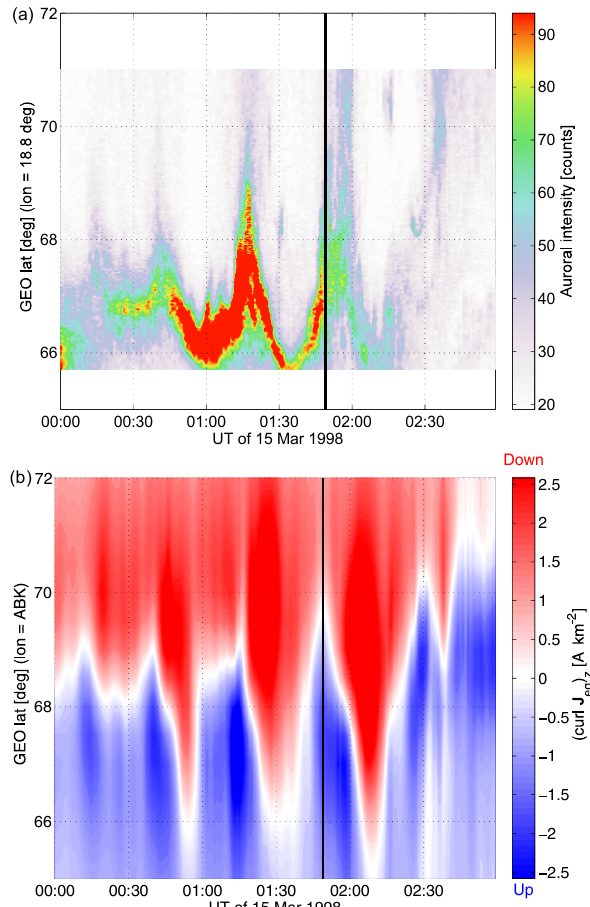
Figure 7. Evolution of the auroral brightness (a) and the equivalent current vorticity (b) as a function of time and geographic latitude for an omega event on 15 March 1998. The vertical line marks the individual omega structure in Fig. 6 at 01:49UT. Other omega struc- tures took place at 00:12, 00:17 and 00:40UT. The curl of the equiv- alent currents gives an estimate of the field-aligned current distribu- tion downward (red) and upward (blue) in Akm − 2 . ASC data are plotted in relative brightness units (counts) and false colour. Both keograms are plotted along the longitude of the ABK camera sta- tion (18.8 ◦